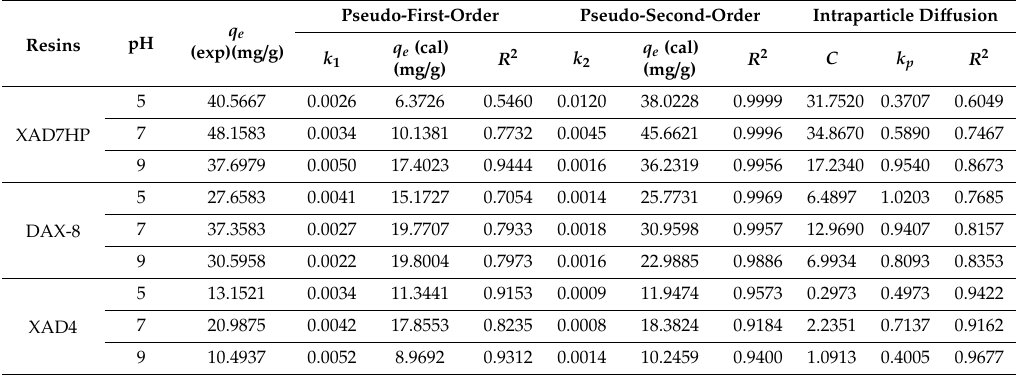
Table 1. Pseudo-first-order and pseudo-second-order kinetics equations and related model parameters of OPL total flavonoids on the selected MARs.